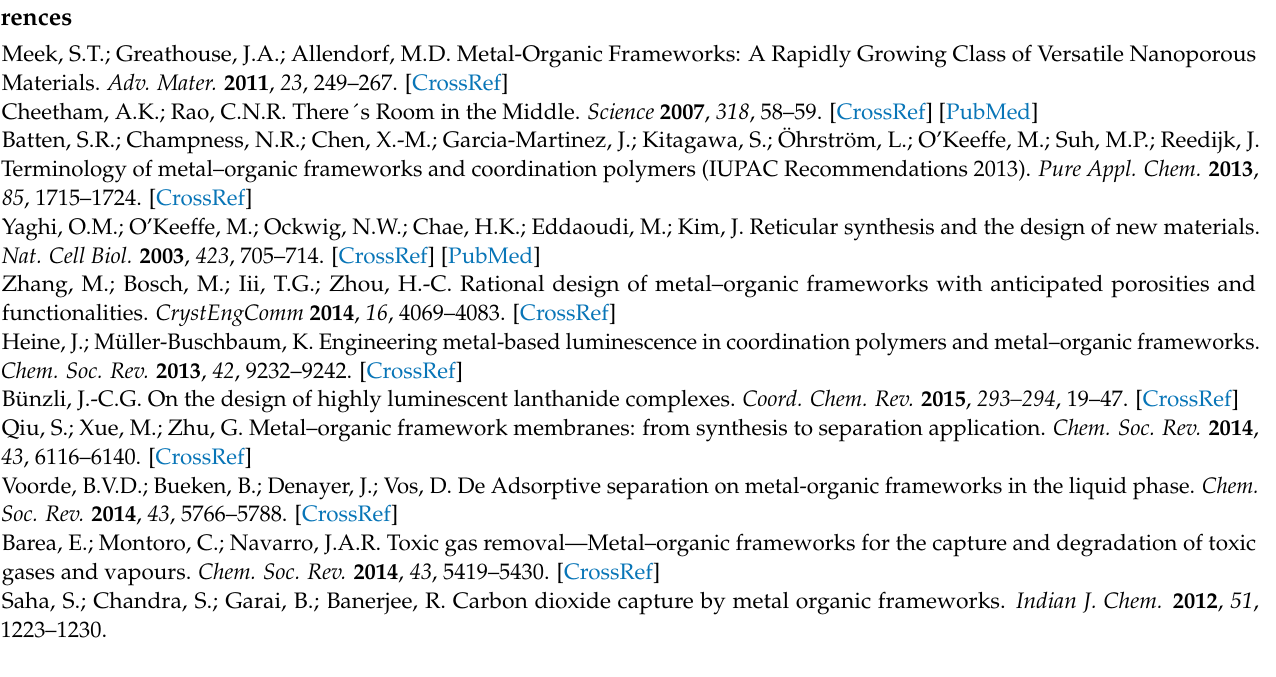
components of the ac susceptibility for 4 under an external field of 1000 Oe (the susceptibility values are given per Er(III) ion, Figure S7: Cole–Cole plots under 1000 Oe external field for 1 . Solid lines represent the best fits to the generalized Debye model, Figure S8: Excitation spectrum of compound 2 measured at room temperature at λ em = 548 nm, Figure S9: Excitation spectrum of compound 2 measured at room temperature at λ em = 548 nm, Figure S10: Decay curves of compound 2 acquired on dispersions of different solvents (see specified conditions), Table S1: Data of pattern-matching refinement of compound 2 , Table S2: Data of pattern-matching refinement of compound 3 , Table S3: Data of pattern-matching refinement of compound 4 , Table S4: Continuous Shape Measures Cal- culations for herein described compound 1 , and previously reported {[Nd(ant) 1.5 (DMF) 2 ] · (DMF)} n , uous Shape Measures Calculations for the isostructural Dy-based analogue of compounds 2 – 4 due to the lack of single crystals of these specimens. The Tb ( 2 ), Ho ( 3 ) and Er ( 4 ) compounds are expected to have similar coordination environments to that of Dy in both